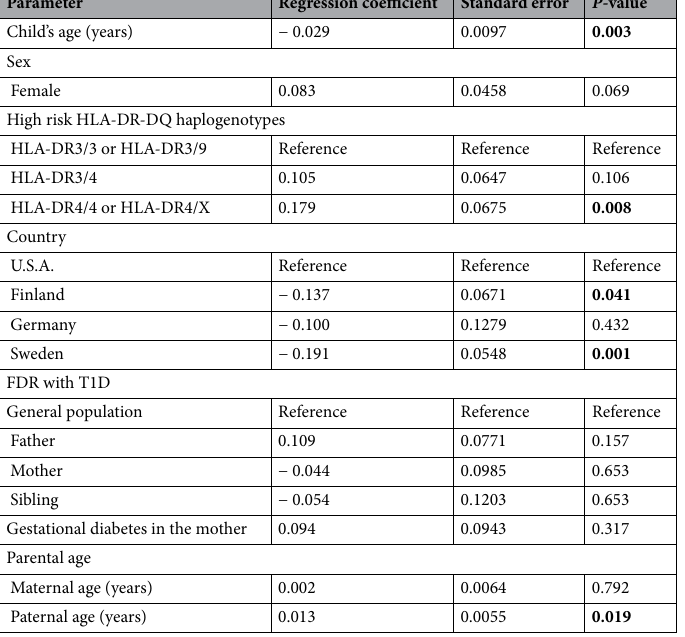
Table 2. Association between telomere length and characteristics of the subjects (sex, high risk HLA-DR-DQ haplogenotypes, country, first-degree relative (FDR) with T1D, gestational diabetes in the mother and parental age). Telomere length data were available on a total of 1119 TEDDY children. The age at sample collection and the indicator of the long-distance protocol sample collection (yes vs. no) were also included in the